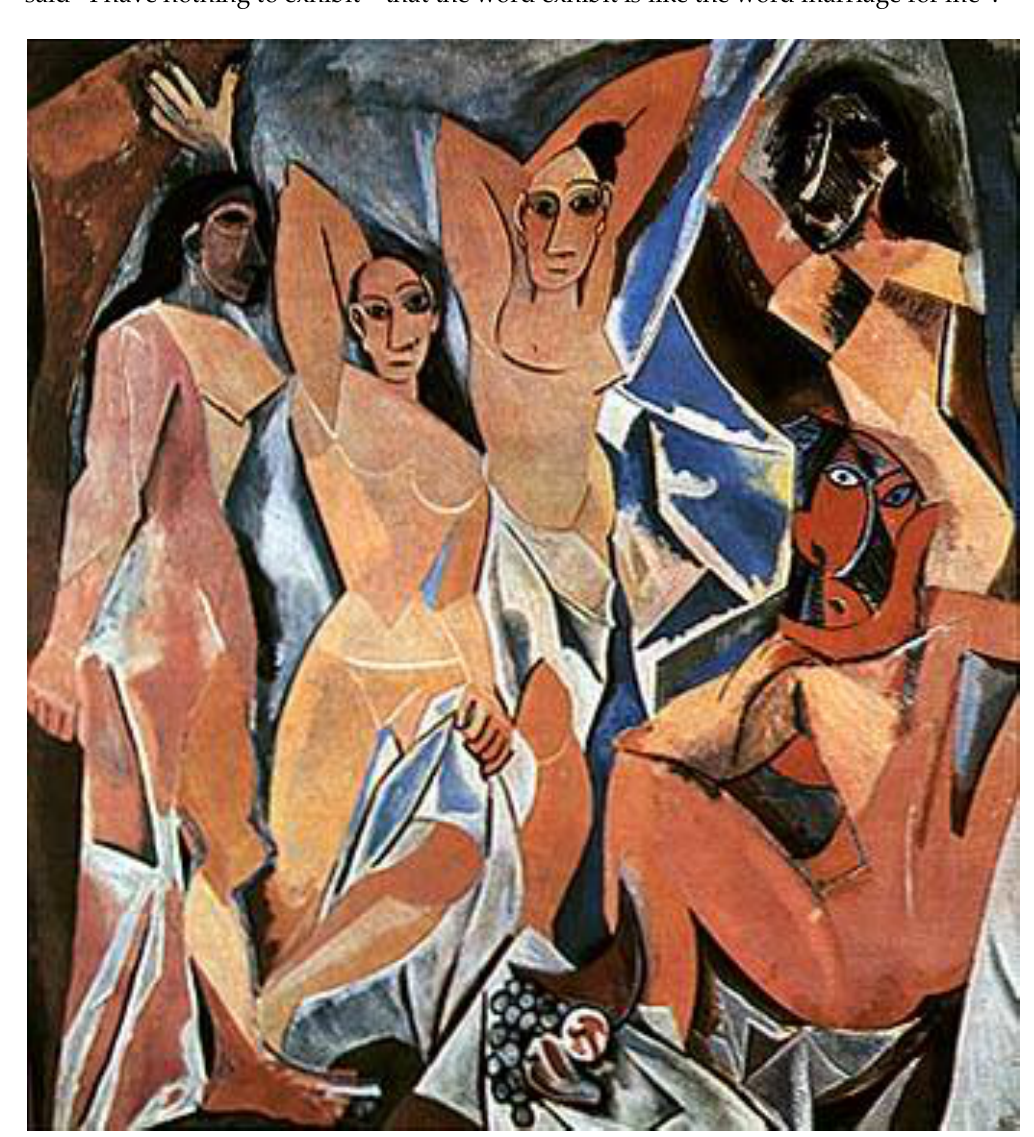
Figure 4. Pablo Picasso, 1906–1907, Les demoiselles d’Avignon, MoMA, New